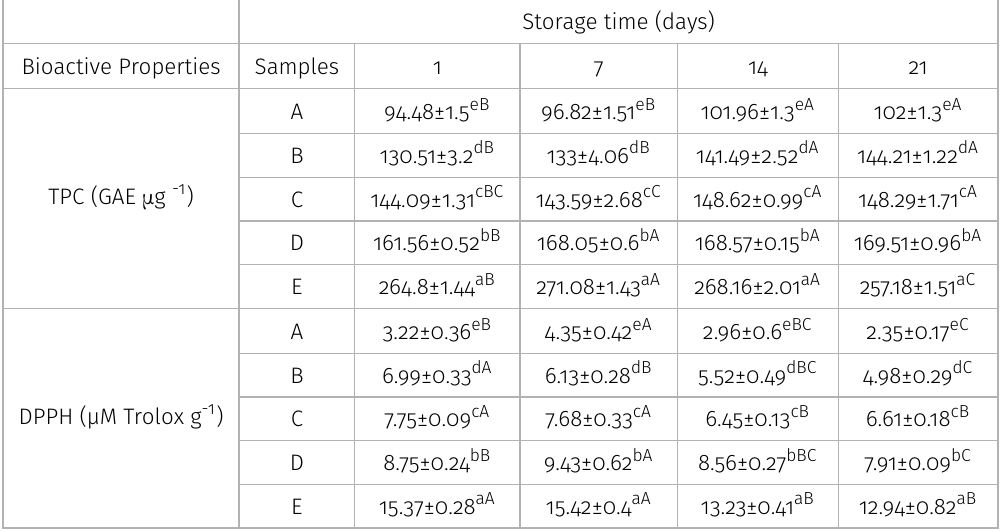
Table IV. Bioactive properties of yoghurt-like product produced with cow milk and hazelnut beverage during storage at 4